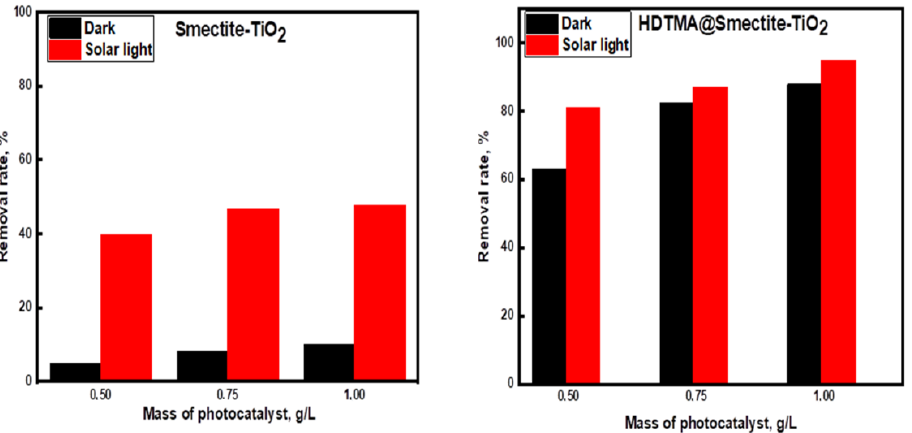
Figure 4. Effect of photocatalyst mass (Smectite-TiO 2 and HDTMA@Smectite-TiO 2 ) on the removal of diclofenac by adsorption and photocatalytic activity under solar light, [diclofenac]: 100 ppm, contact time 90 min.